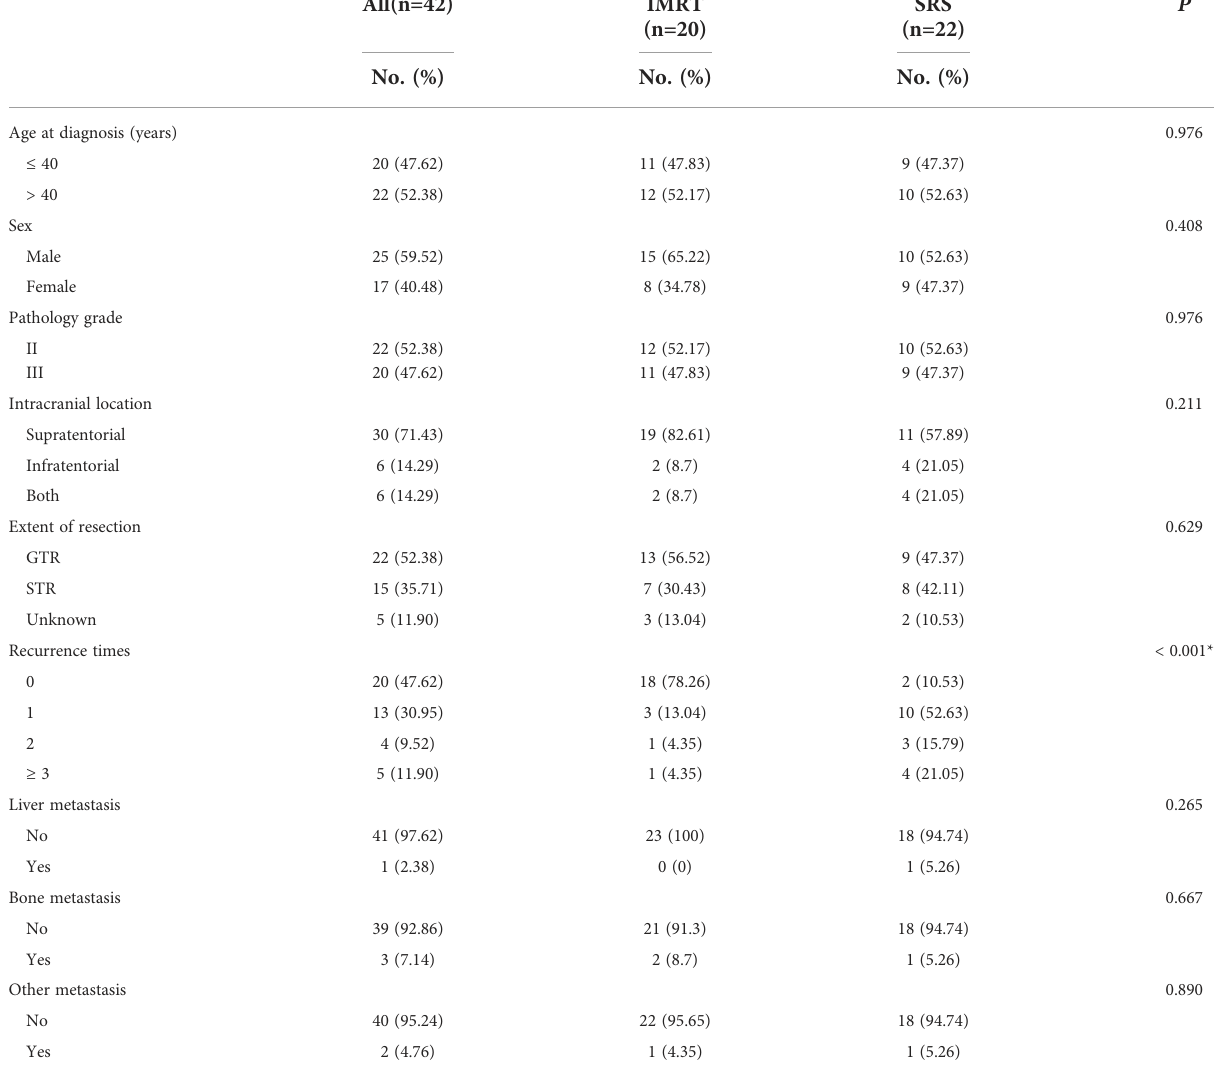
TABLE 1 Characteristics of patients with SFT/HPC receiving postoperative radiotherapy divided by radiotherapy